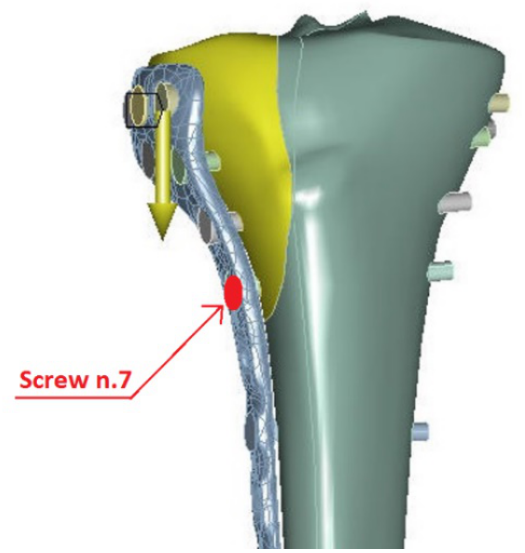
Figure 12. Position of screw n.7.